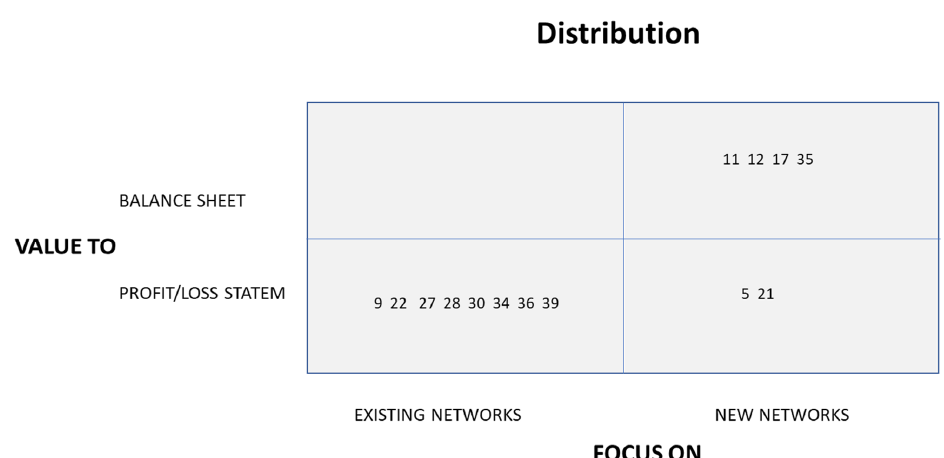
Figure 9. Articles plotted in two dimensions based on the type of value that is created, involving either improved Profit and loss statement or reduced capital employed (balance sheet). Each article is numbered, where the lowest number corresponds to the highest citation rate, as in the previous figure.